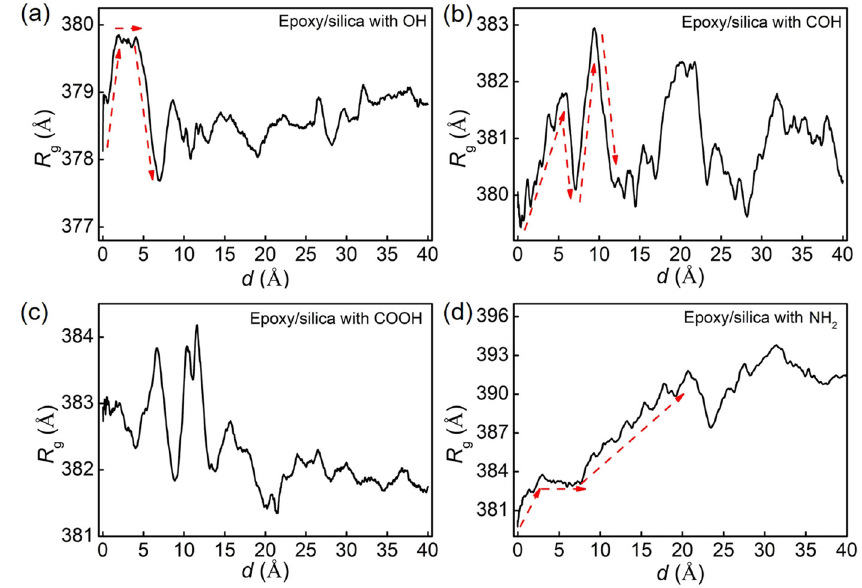
Figure 10: R g of epoxy as a function of displacement during pulling for ( a ) the system with hydroxyl groups; ( b ) the system with formyl groups; ( c ) the system with carboxyl groups; and ( d ) the system with amine groups. R g increases obviously at the beginning stage of pulling, consistent with the linear increment in pulling force. When the interface fails, R g reaches the local